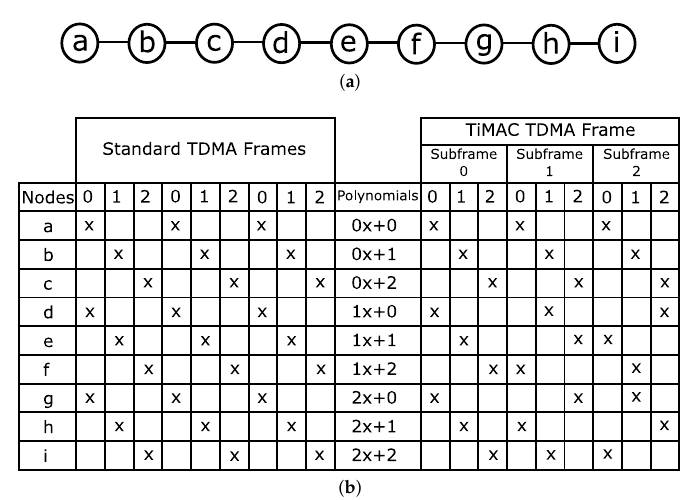
Figure 1. ( a ) a chain topology of nine nodes; ( b ) traditional and TiMAC TDMA Frame examples.